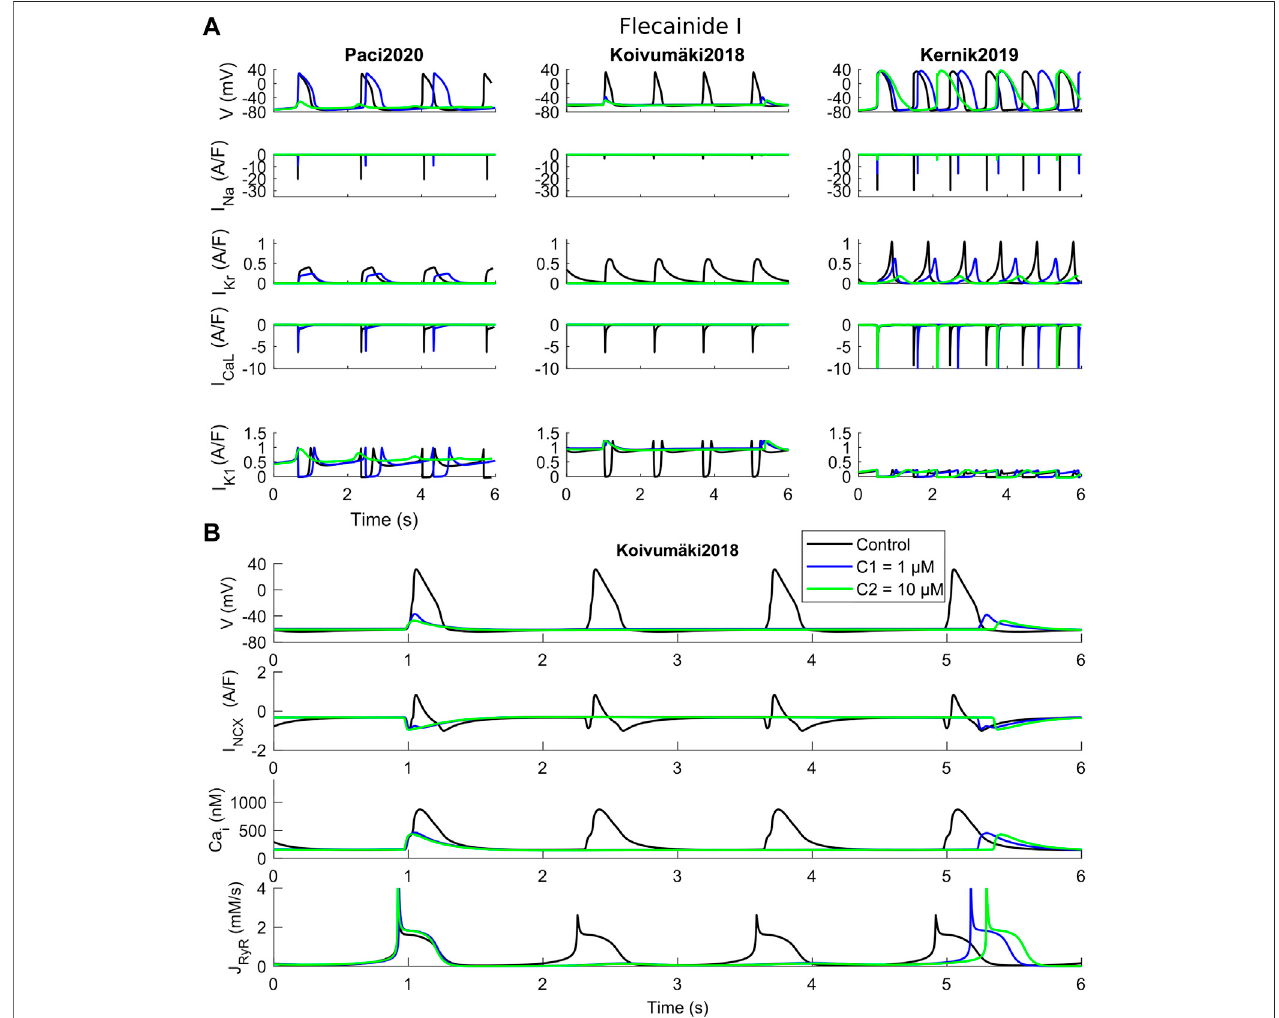
FIGURE 4 | Effects of fl ecainide I on the three in silico models for the two tested concentrations (C1 and C2). (A) Comparison of action potentials, Ca 2+ transients and ion currents. (B) Detail ofthe Koivumäki2018traces, showingaresidualactivity due tospontaneous Ca 2+ releases from thesarcoplasmicreticulum thatactivate the inward component of I NCX